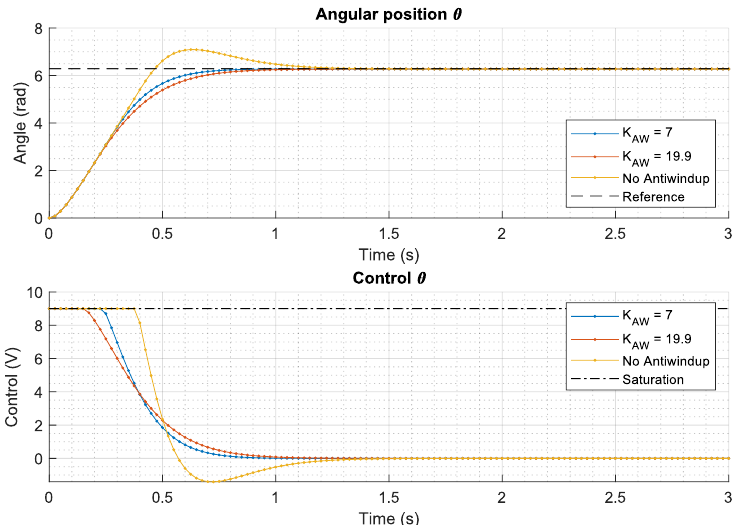
Figure 8. Antiwindup scheme